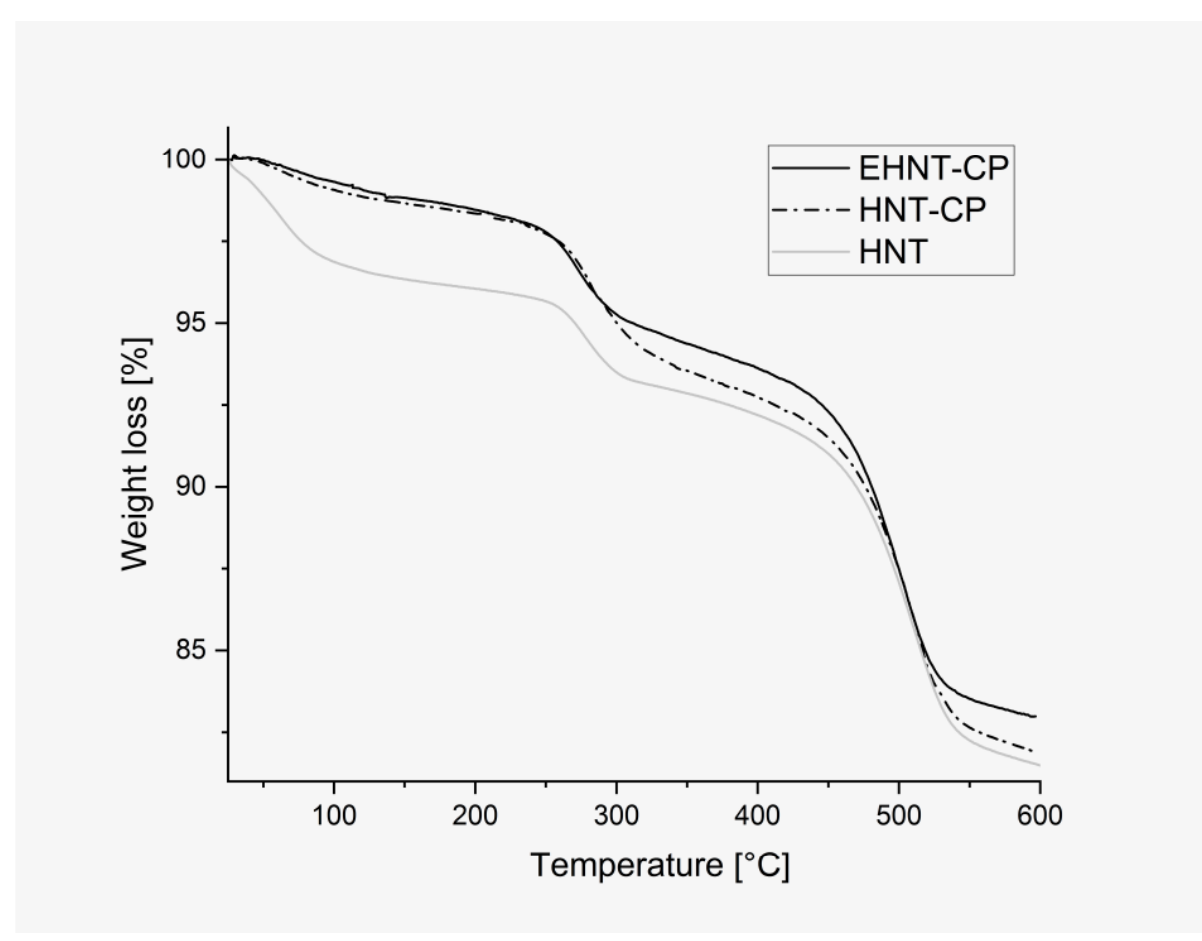
Figure 2. Thermogravimetric curves for HNT, HNT-CP and EHNT-CP. 3.1.2. Studies of CP Release from HNT and EHNT